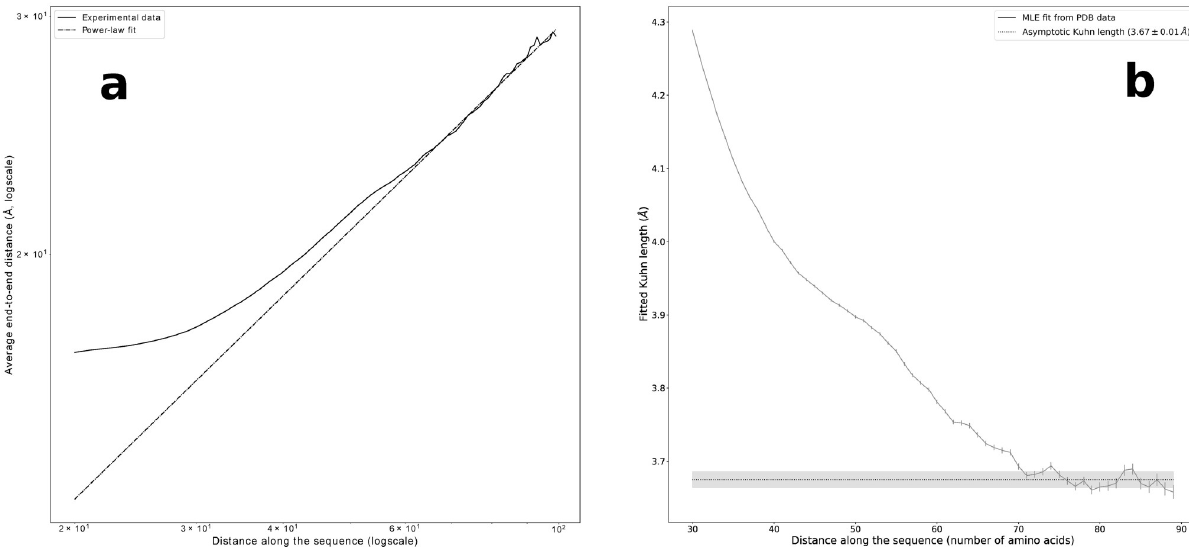
Fig 1. Gaussian statistics for buried fragments: The thermal exponent and the Kuhn length. ( a ) Log-log plot of the average CA end-to-end distance R of protein fragments versus fragment length m . The plot was obtained by averaging over all fragments of length m from the data set selected as shown in S2 Fig in S1 File. For any given m , R was determined as the average over all fragments of that length in proteins whose overall lengths are larger than m 3 2 , in order to consider only fragments likely to be buried in the globule interior [52]. The error bars are of the order of the size of the symbols. The Flory regime, e.g. R � m 1 2 is reached when m � 70. For m > 90 the statistical analysis deteriorates due to the fast decrease of available data with increasing m . ( b ) The Kuhn length b , obtained by maximizing the likelihood to Maxwellian distributions (1) of the empirical CA end-to-end distance data, plotted versus the length m of the protein fragments considered in the statistical analysis. The error bars were estimated based on the Fisher information evaluated at b ( m ) (see main text). The values of b decrease monotonically and reach a plateau in the region 70 � m � 90. The plateau uniform value is estimated to be b � = 3.67 ± 0.01 Å . Only in this region all the rescaled empirical distributions collapse (see Fig 3), thereby showing the existence of the Flory regime. The number of fragments in the ensembles which are analyzed decreases with m as well. For m > 90 the ensemble population becomes too small to allow good estimations. Figure drawn with python package matplotlib, version 3.4.1. URL https://pypi.org/project/ matplotlib/.